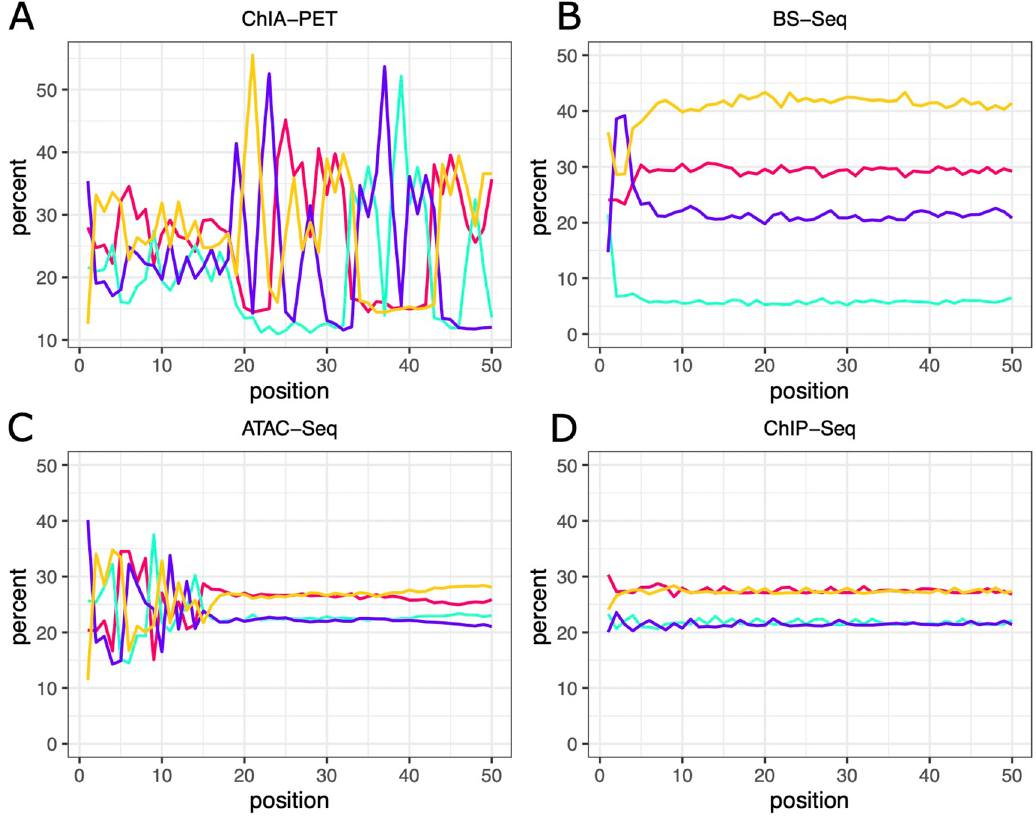
Figure 1. Per position base content for different library types. Base content across the first 50 positions of the sequencing reads was averaged for 54 ChIA-PET, 436 Bisulfite-seq, 416 ATAC-seq and 449 ChIP-seq libraries from mouse and human. Percentages are plotted for each of the four